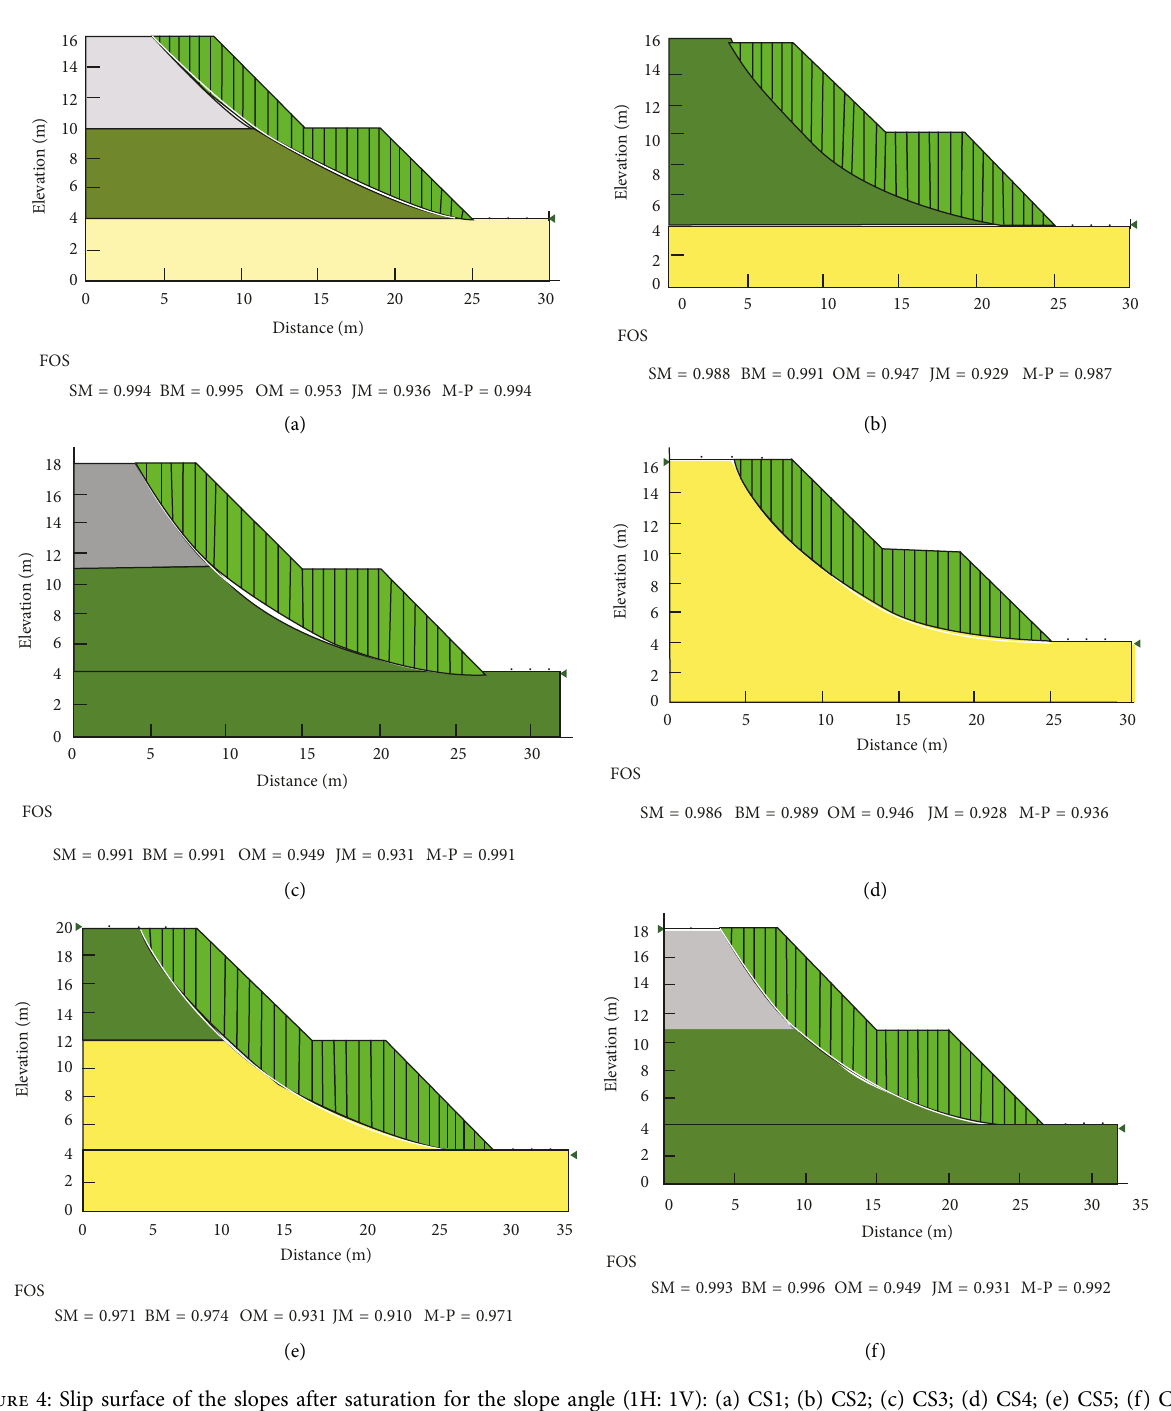
Figure 4: Slip surface of the slopes after saturation for the slope angle (1H: 1V): (a) CS1; (b) CS2; (c) CS3; (d) CS4; (e) CS5; (f)